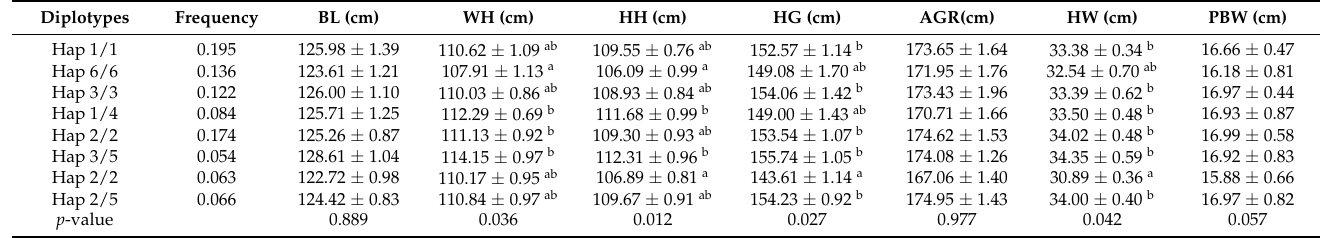
Table 7. Associations analysis of diplotypes with body conformation traits in Dabieshan